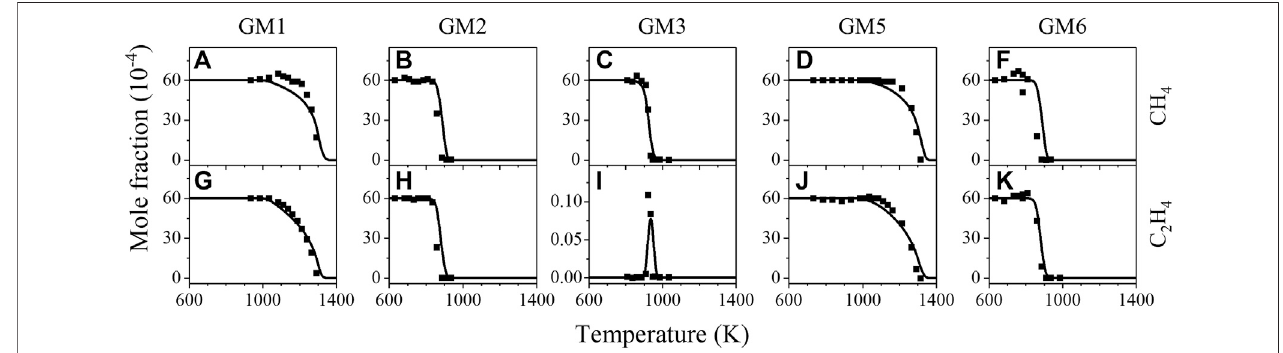
FIGURE 4 | Experimental (symbols) and simulated (lines) mole fraction pro fi les of methane (CH 4 ) and ethylene (C 2 H 4 ) in the oxidation GM1, GM2, GM5 and GM6.